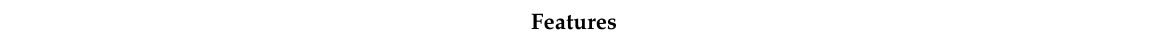
Table 2. Advantages of the proposed